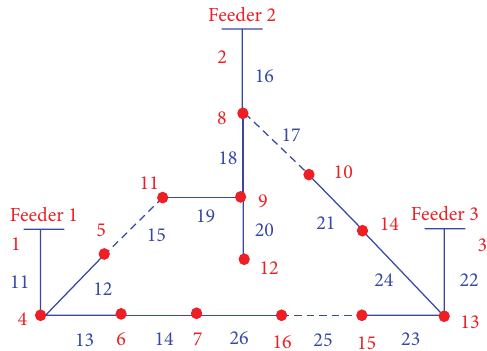
Figure 1: Power distribution system for optimal reconfiguration.